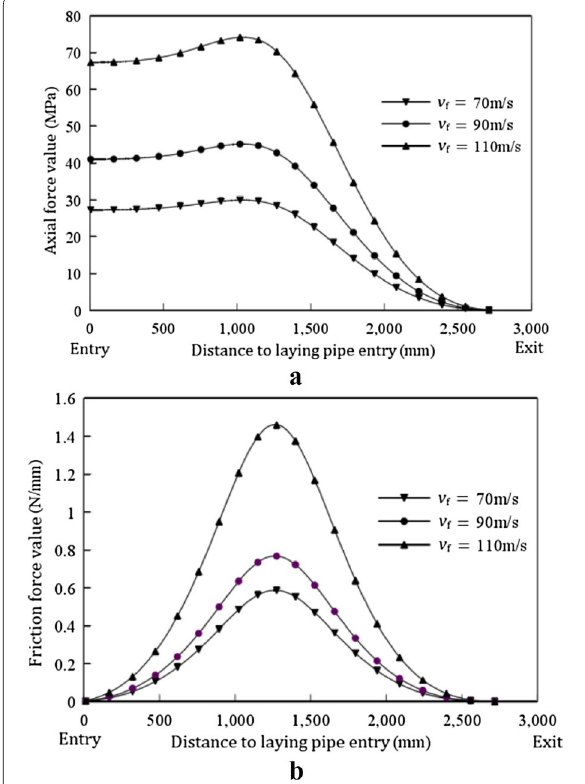
Figure 19 Numerical results with different feeding speed: a Axial force in the design laying pipe; b Friction force in the design laying